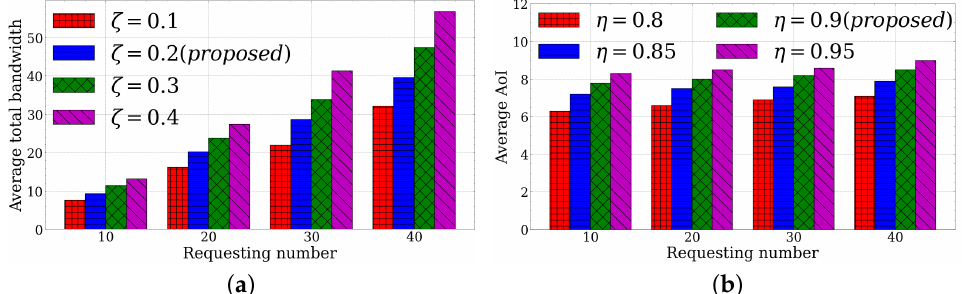
Figure 2. LLUC evaluation under different learning rates and training round proportions. ( a ) Learning rate. ( b ) Proportion of training